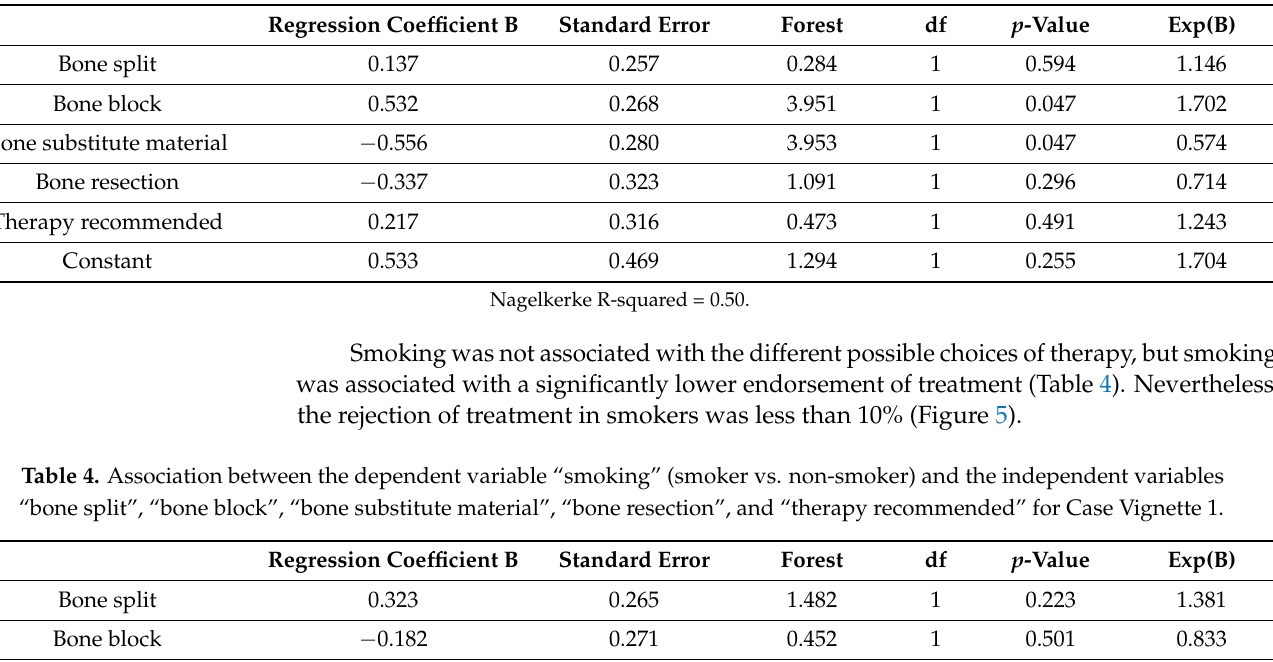
Table 3. Association between the dependent variable “patient age” (55 years vs. 75 years) and the independent variables “bone split”, “bone block”, “bone substitute material”, “bone resection”, and “therapy recommended” for Case Vignette 1.